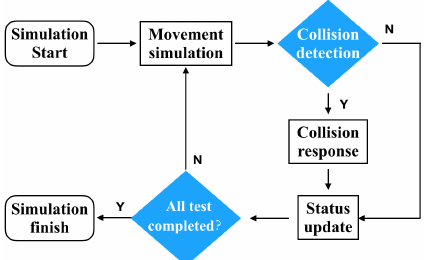
Figure 4. Flow chart of particle system dynamic simulations.